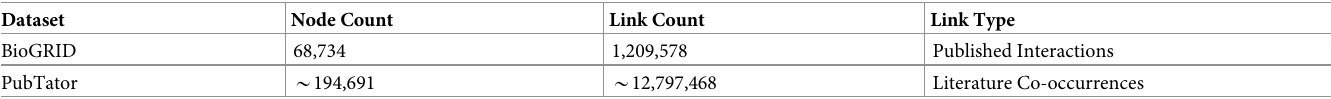
Table 1. Graph details (undirected link